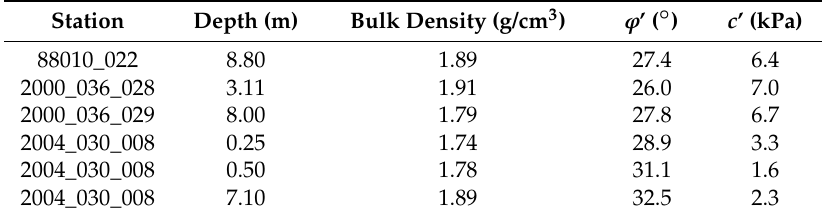
Figure 3. Geotechnical profile for core 20000360029PC (w = natural in-situ water content, PL = plastic limit, LL = liquid limit), as an example of the data available for each core in this study. Table 1. Summary of isotopically consolidated undrained CIU multi-stage triaxial tests ( ϕ ’ is the effective friction angle and c ’ is the effective cohesion). The piston core locations for the triaxial samples are highlighted in red in Figure 2A.